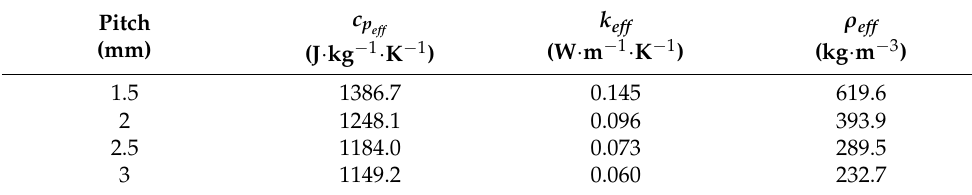
Table 5. Effective properties of the insole.